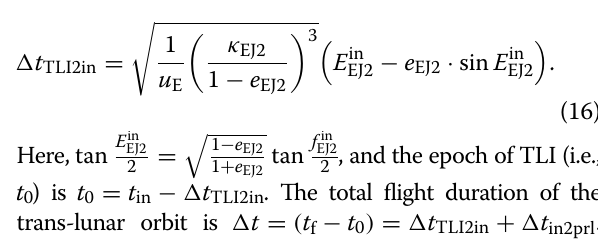
The expressions in Eqs. (8 , 9, 10, 11, 12, 13, 14, 15, 16) are the so-called retrograde semi-analytical model, which is proposed to compute the trans-lunar orbit rapidly. Multiple‑layer traversal search Based on the retrograde semi-analytical model, a multi- layer traversal search method is utilized to generate the reachable set of the trans-lunar orbits rapidly. The flow chart is shown in Fig. 5. are selected as the traversal searching ele- ments in a four-layer frame respectively. Then, κ EJ2 , e EJ2 , i EJ2 , and, f in EJ2 are tested by the constraints. If any con- straint is not satisfied, the next loop will be re-started. Considering the error of the double two-body model, an error of the radius of perigee �κ EJ2 is allowable as Eq. (17).